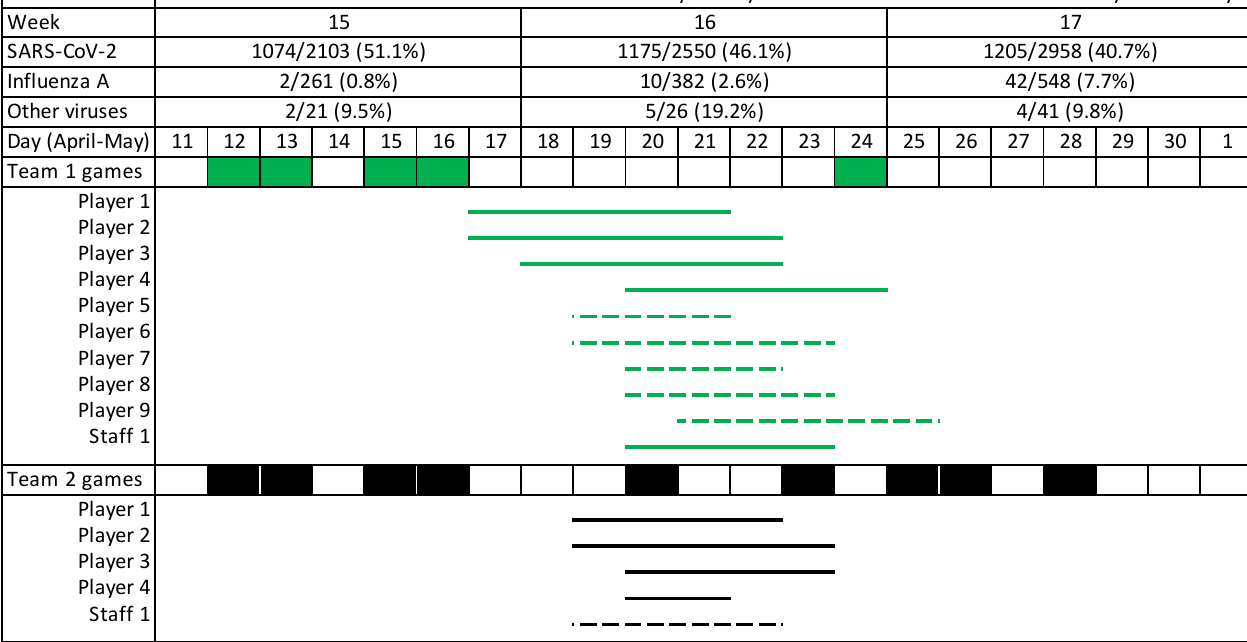
Figure 1. Timeline of influenza A virus outbreak in two ice hockey teams and background occurrence of respiratory viruses in the community as reported from the Hospital District of Southwest Finland. SARS-CoV-2 numbers result from community surveillance and diagnosis of hospital patients, numbers of influenza A and other viruses from hospital patients only. Teams played against each other on 12, 13, 15, and 16 April, thereafter against other teams. Lines indicate sick players with (solid line) or without (broken line) confirmed influenza A virus. Other viruses (n) included rhinovirus (4), human metapneumovirus (4), and seasonal coronaviruses 229E (2) and NL63 (1). * Positive specimens/tests performed.